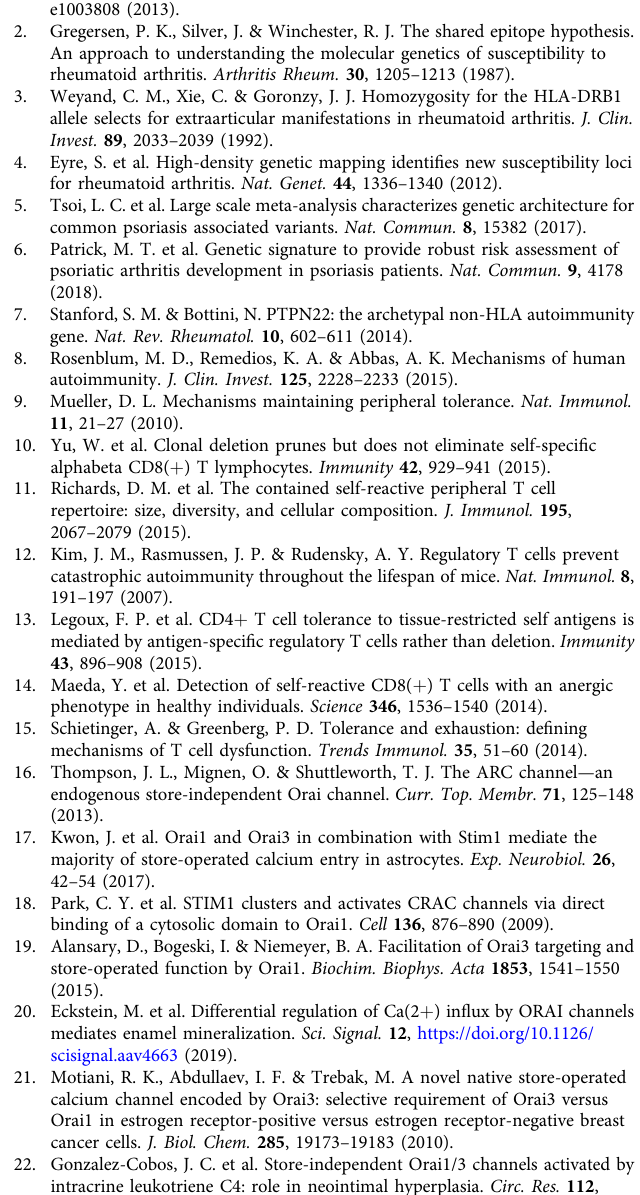
Fig. 8 Reduced IKAROS expression in RA CD4 + T cells promotes synovial in fl ammation. a Chromatin accessibility maps of naive and central memory (CM) CD4 + T cells from RA patients, PsA patients, and healthy individuals were generated by ATAC-seq. Accessible regions at TSS region (chr7:50,342,000 – 5000) of IKFZ1 encoding IKAROS. b IKFZ1 expression in puri fi ed CD4 + naive T cells from HC ( n = 22), RA ( n = 21), PsA ( n = 10), and SLE ( n = 7) patients was quanti fi ed by qPCR. Data are presented as dot plots with mean ± SEM. c Representative immunoblots of IKAROS in CD4 + naive T cells from HC and RA patients (left); dot plot of IKAROS intensities normalized to β -actin from HCs ( n = 10) and RA ( n = 8) (right). Data are presented as dot plots with mean ± SEM. Uncropped Western blots in Supplementary Fig. 10. d , e NSG mice engrafted with human synovial tissue were reconstituted with HC CD45RO – PBMC transfected with control or IKAROS siRNA. Tissue was collected on day 7 after reconstitution and analyzed. d Three-color immuno fl uorescence staining of tissue sections for IFN- γ and CD3 (left). Scale bars, 20 µ m. Frequencies of CD3 + and IFN- γ + CD3 + T cells in synovial tissues are shown as mean ± SEM of 12 synovial grafts for each treatment arm pooled from 6 mice (right). e Expression of genes encoding lineage- determining transcription factors and key in fl ammatory markers as determined by RT-PCR. Results from tissues of mice adoptively transferred with control cells are shown as white bars and circles, those from mice with IKAROS-silenced cells as gray bars and squares. Data are presented as dot plots with mean ± SEM. Data in b were analyzed by one-way ANOVA followed by Tukey ’ s multiple comparison test; data in c – e were analyzed by unpaired two-tailed Student ’ s t test. n.s. not signi fi cant. Source data are provided as a Source Data